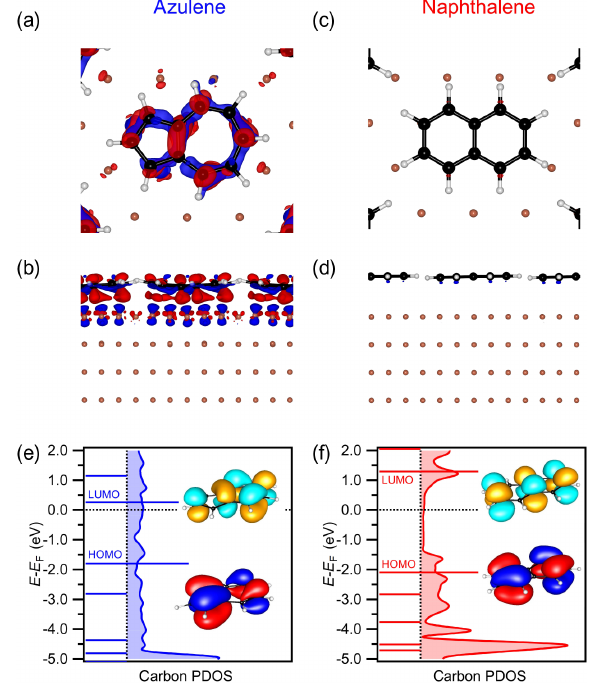
FIG. 9. Electronic structure of azulene and naphthalene on Cu(111) from DFT calculations. (a,b) Charge density difference plots for azulene. (c,d) Charge density difference plots for naphthalene. The isosurface value is 0 . 003 e − = Å; electrons flow from blue to red. In panel (a), electron enrichment in the shape of the LUMO is clearly visible. (e,f) Carbon partial density of states of the adsorbed species. The horizontal bars represent the energies of the frontier orbitals of the free molecules. These energy levels are shifted to align the lowest valence orbitals for the free and the adsorbed molecules. The figure also shows images of the HOMO and LUMO as calculated by